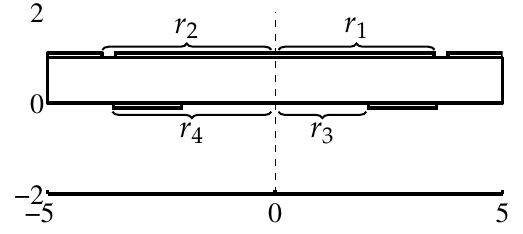
Figure 8. Reference initial geometry in millimetres; r 1 = 3 . 5 ; r 2 = 3 . 8 ; r 3 = 2 . 05 ; r 4 = 3 .